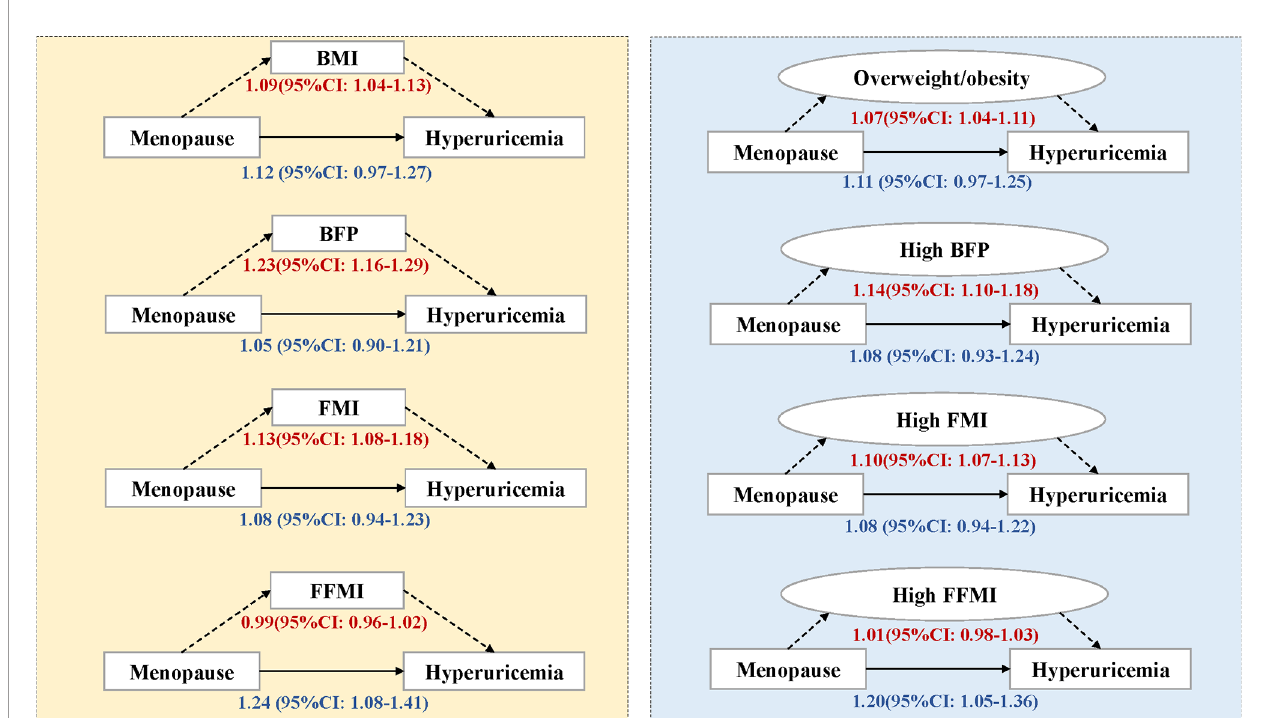
FIGURE 3 | Mediation analysis of body composition on the association between menopause and hyperuricemia. The number represents odds ratios and their 95% con fi dence intervals in the direct or indirect effect estimates. BMI, body mass index, kg/m 2 ; BFP, body fat percentage, %; FMI, fat mass index, kg/m 2 ; FFMI, fat free mass index, kg/m 2 ; CI, con fi dence interval. Overweight/obesity refers to BMI ≥ 24, high BFP refers to BFP>32%, high FMI refers to FMI>7, and high FFMI refers to